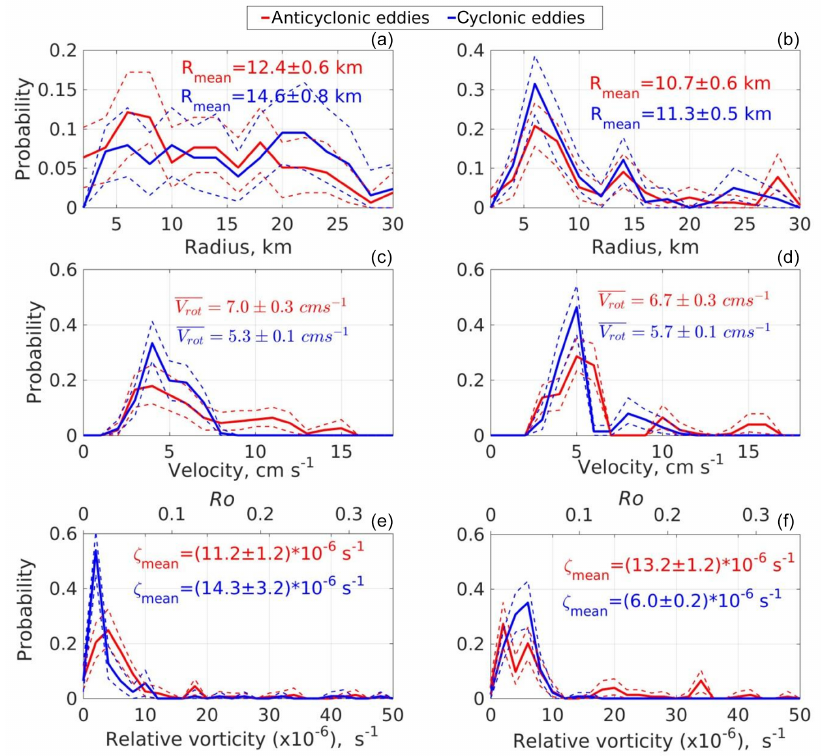
Figure 7. Probability distribution function of eddy radii (a, b) , rotational current speed (c, d) , and relative vorticity (e, f) estimated using ADCP records collected at 125m (a, c, e) and 290m (b, d, f) at mooring M1g. Dotted lines indicate the 95% confidence interval estimated by the bootstrap method. Red is used for anticyclonic eddies; blue is cyclonic